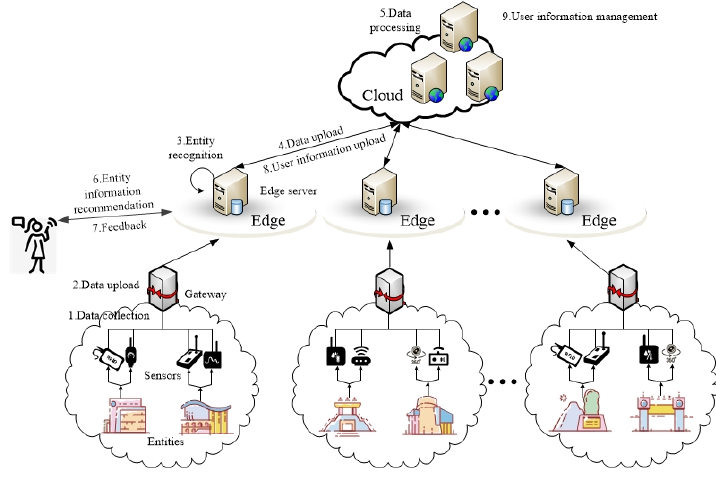
Figure 1. Recommendation system